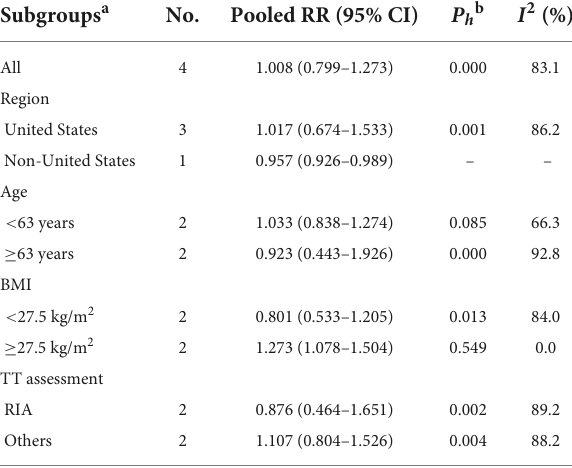
TABLE 5 Subgroup analysis for the association of total testosterone and atrial fibrillation risk in men.